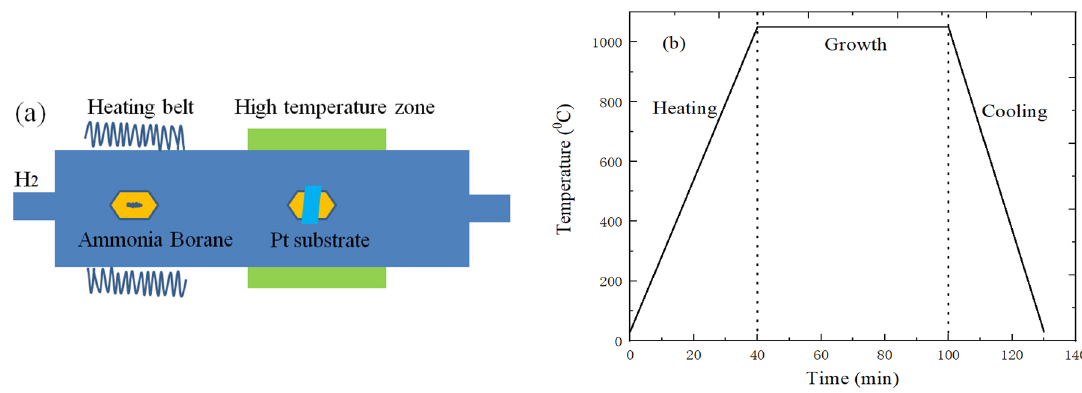
Figure 1. ( a ) Growth schematic diagram; ( b ) CVD temperature change curve of h-BN preparation.